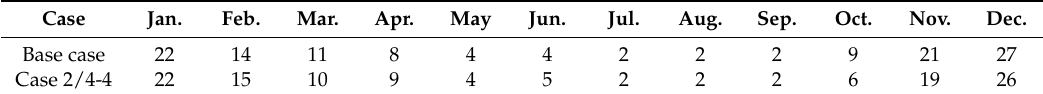
Table 11. MD non-operational